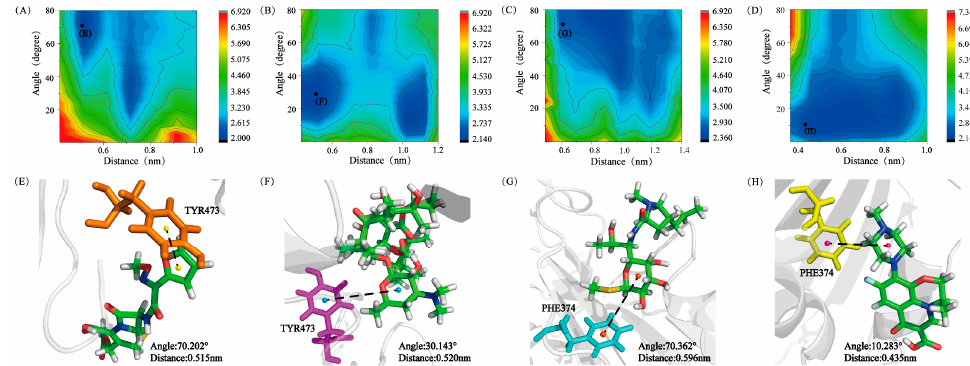
Figure 6. Analysis of aromatic stacking interactions between the aromatic heterocycle of the inhibitors and aromatic residues. The free energy landscape as a function of the centroid distance and the angle between the rings of aromatic residues of S_RBD and the benzene-like rings of inhibitors for ( A ) TYR473 and Cefuroxime in the S_RBD with Cefuroxime system, ( B ) TYR473 and Erythromycin in the S_RBD with Erythromycin system, ( C ) PHE374 and Lincomycin in the S_RBD with Lincomycin system and ( D ) PHE374 and Ofloxacin in the S_RBD with Ofloxacin system. Representative snapshots using PyMOL showing a perpendicular-aligned stacking orientation between the aromatic ring of TYR473 and the benzene-like ring of Cefuroxime ( E ) in the S_RBD with Cefuroxime system, a herringbone–aligned stacking orientation between the aromatic ring of TYR473 and the benzene-like ring of Erythromycin ( F ) in the S_RBD with Erythromycin system, a perpendicular–aligned stacking orientation between the aromatic ring of PHE374 and the benzene-like ring of Lincomycin ( G ) in the S_RBD with Lincomycin system and a parallel–aligned stacking orientation between the aromatic ring of PHE374 and the benzene-like ring of Ofloxacin ( H ) in the S_RBD with Ofloxacin system.